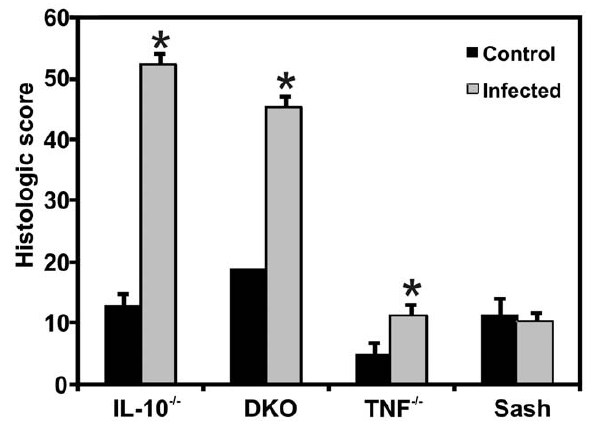
Figure 3. Mast cells do not affect early colitis severity in Helicobacter-infected Il10 2 / 2 mice. Both IL-10-deficient and DKO mice exhibited severe colonic inflammation when infected with H. rodentium and H. typhlonius for 30 d (n=3 for Ill0 2 / 2 and n=4 for DKO mice) compared to Tnf 2 / 2 and sash mice (n=4 each) ( p , 0.001 for both Il10 2 / 2 and DKO vs. Tnf 2 / 2 and sash). * indicates p , 0.01, comparing control (non-infected) and infected mice of a given genotype.